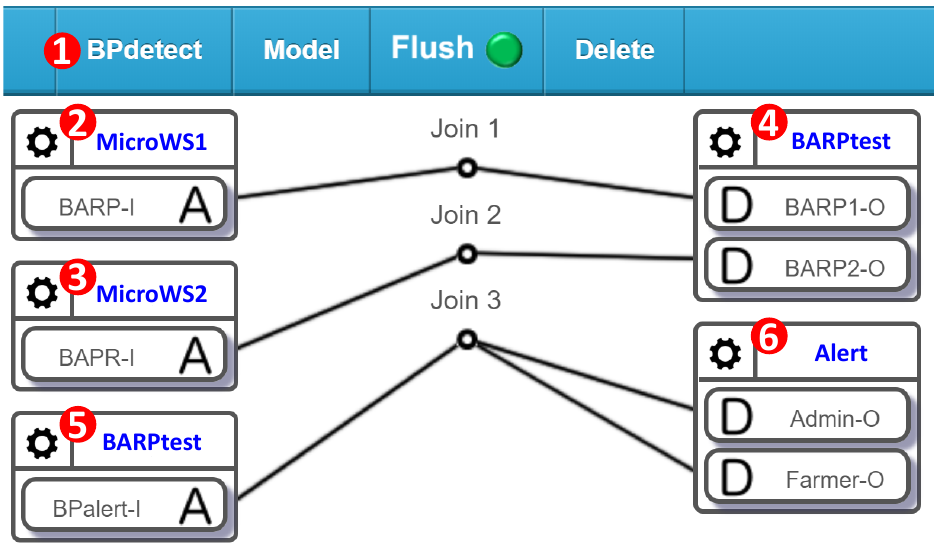
Figure 5. The mutual barometric pressure sensor test in the BPdetect project.